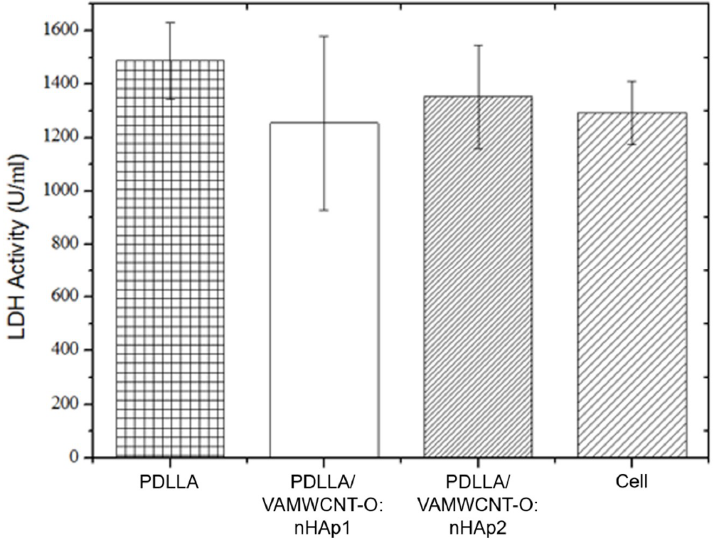
Figure 2. Cell viability of human chondrocytes on PDLLA, PDLLA/VAMWCNT-O:nHAp1, PDLLA/VAMWCNT-O:nHAp2, Cell (Plastic), (N = 3).